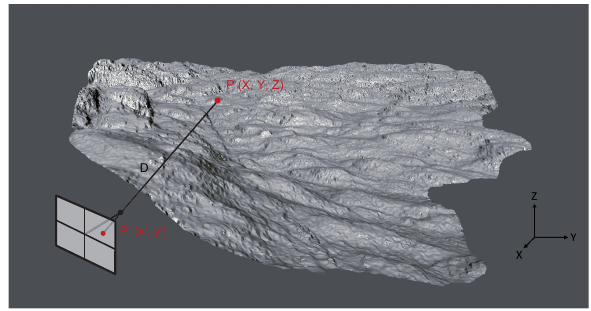
Figure 7. Visualisation of the lake basin (shaded TIN), the orientated time-lapse camera and the intersection between image ray and lake basin model.